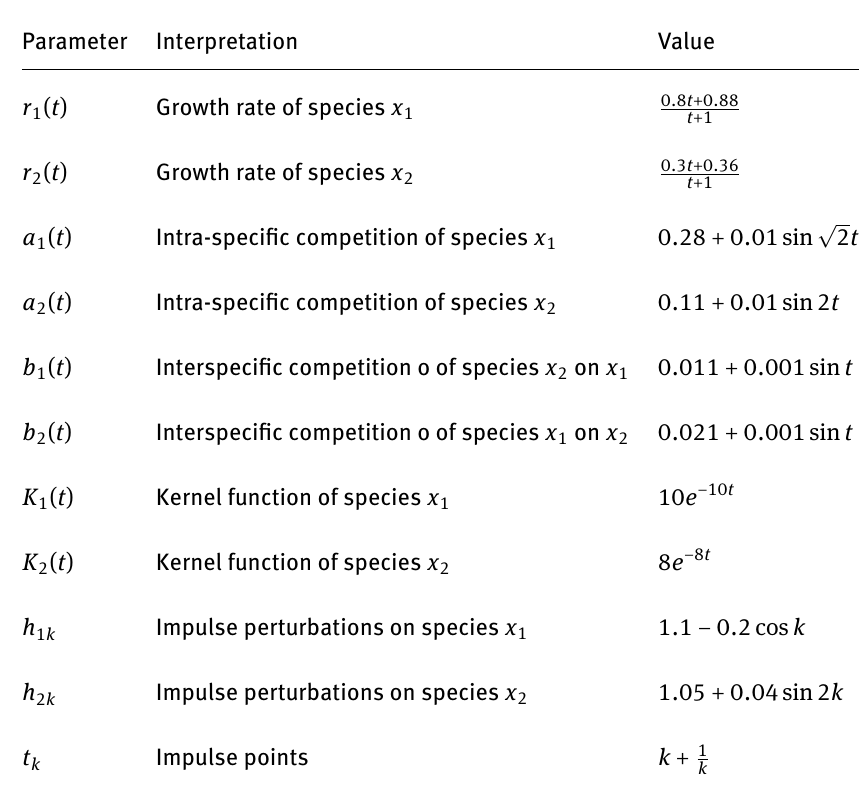
Table 1: Parameter values of system